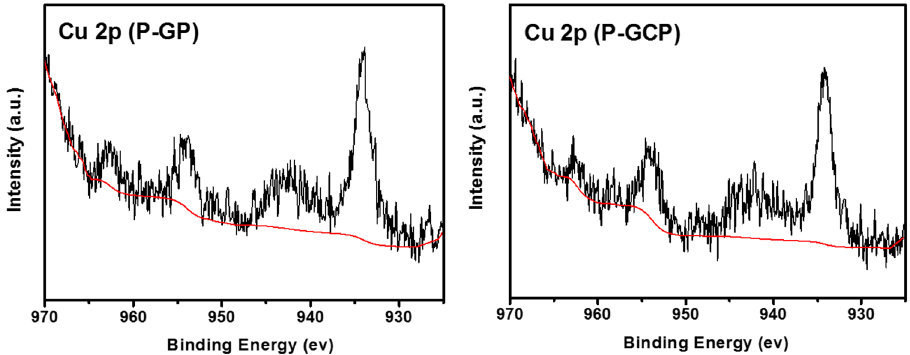
Figure 8. XPS spectrum of Cu 2p in P-GP and P-GCP nanocomposites.